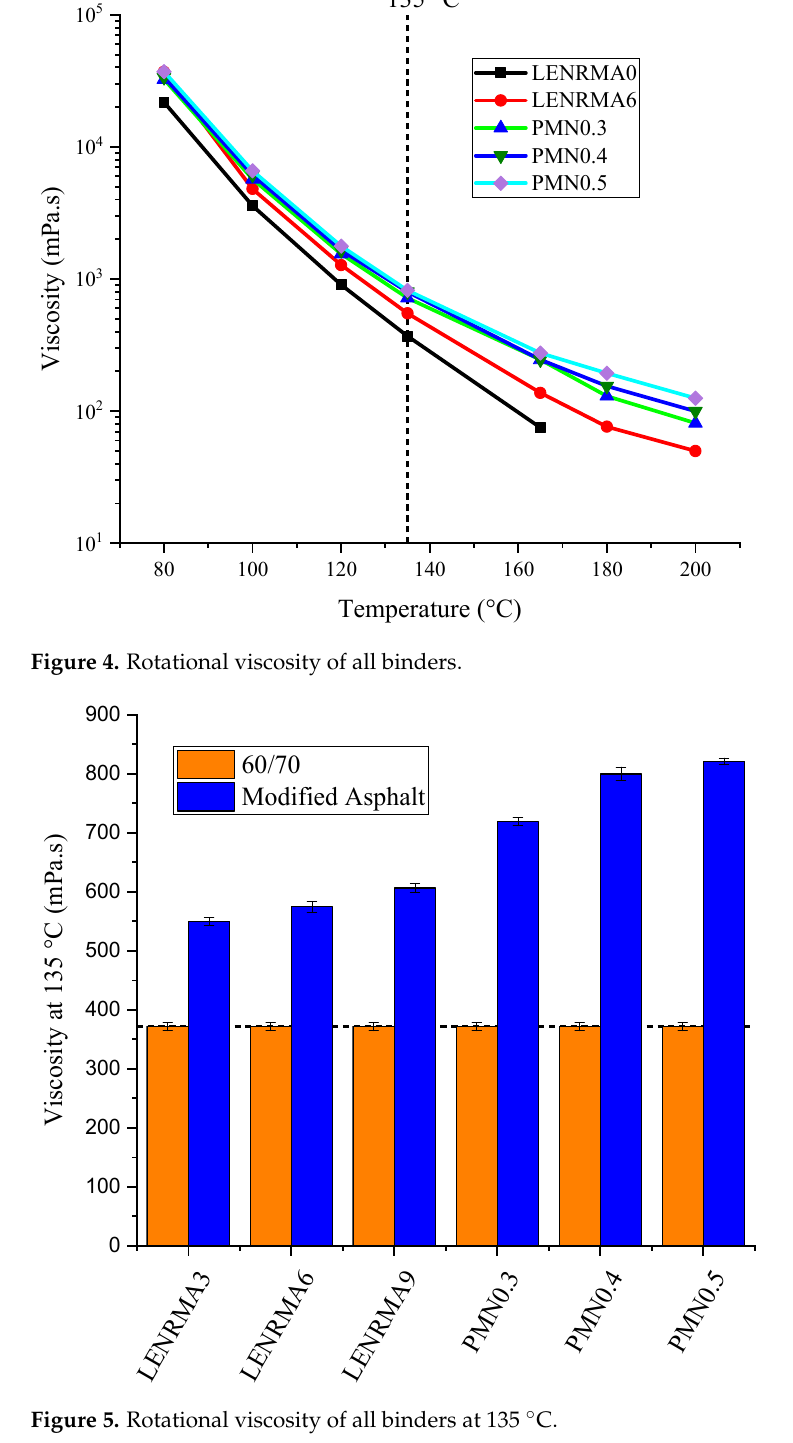
Figure 5. Rotational viscosity of all binders at 135 °C.